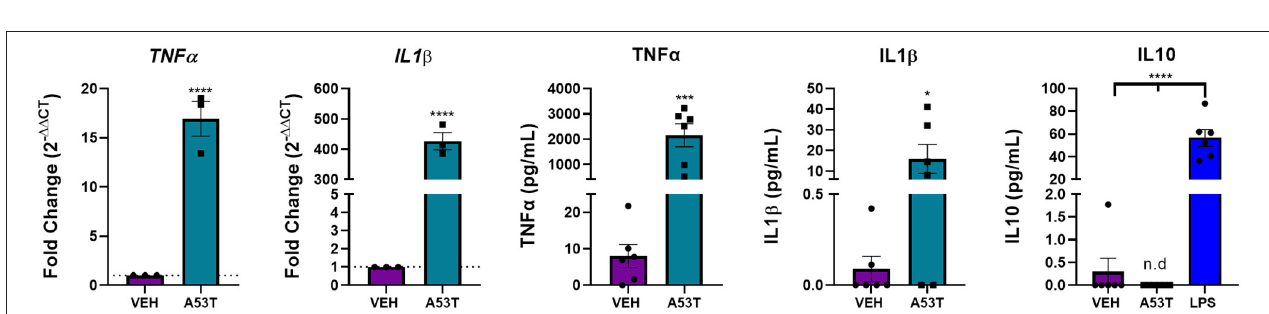
FIGURE 4 | N κ FB nuclear translocation is increased in microglia stimulated by misfolded A53T. Nuclear translocation of NF κ B was analyzed following a 30-min stimulation with 1 µ g/mL misfolded A53T or vehicle (VEH). (A) The presence of cytoplasmic (arrowheads) and nuclear (arrows) NF κ B (red) following immunocytochemistry (nuclei; DAPI, blue). (B) Nuclear translocation of NF κ B was quantified and shown to be significantly elevated in A53T-stimulated microglia compared to vehicle treatment; VEH n = 346 cells and A53T n = 337 cells. Values are reported as mean ± SEM, using an unpaired Student’s t -test; **** P ≤ 0.0001.